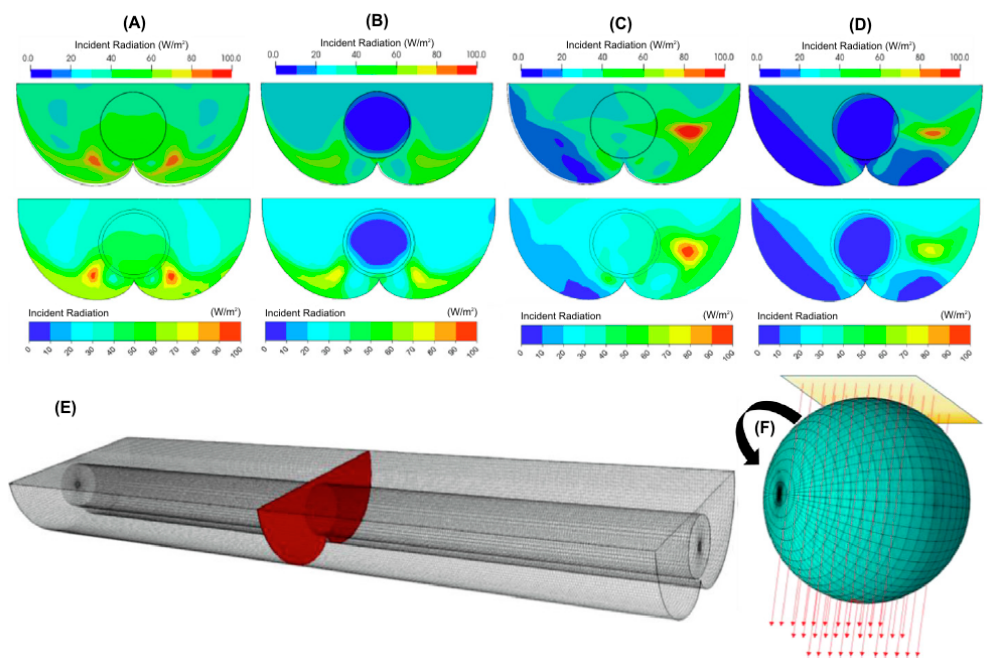
Figure 8. Incident radiation contours in a central plane in a CPC (compound parabolic collector) solar photoreactor; OpenFOAM ( top ) and ANSYS ® Fluent ( bottom ) simulations; emission to normal surface ( A , B ) and at 45 ◦ ( C , D ). No adsorption or scattering ( A , C ) and 0.25 g L − 1 TiO 2 ( B , D ). ( E ) Schematic representation of the analyzed plane. ( F ) Quadrature rotation in parallel sources. Reprinted with permission from [84]. Copyright Elsevier,